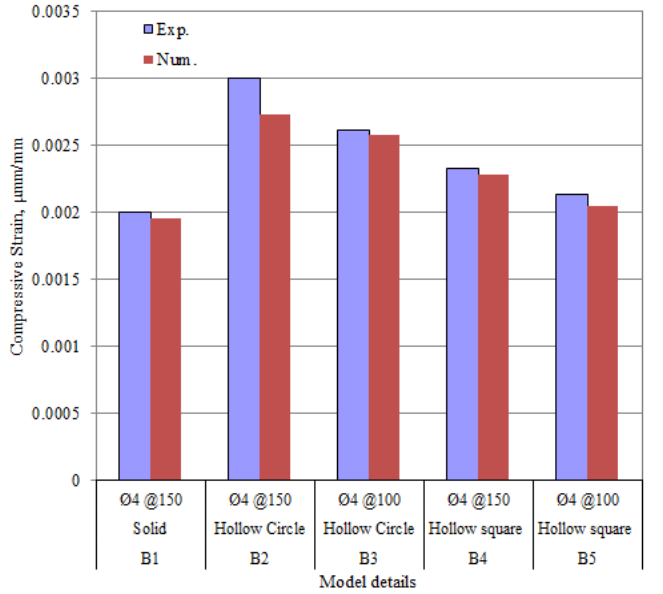
Figure 22. Comparison of experimental and numerical compressive strains of all RC beams.